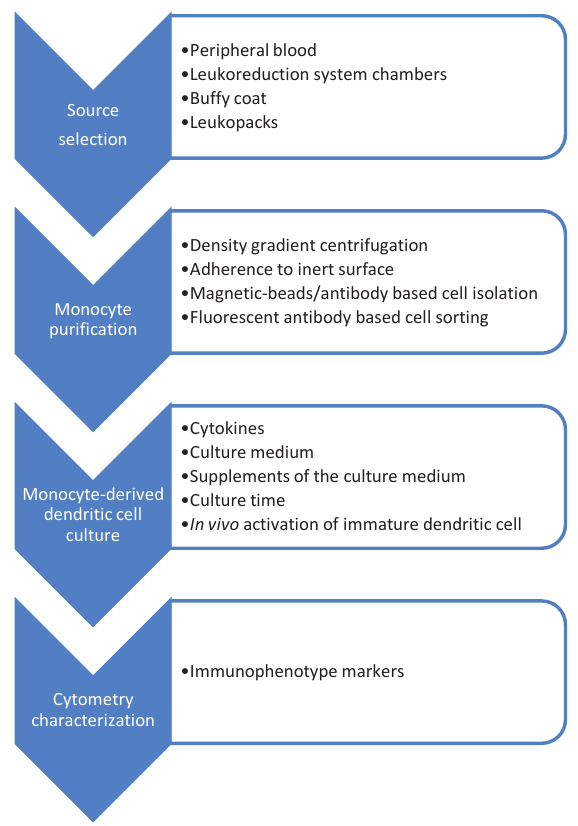
Figure 1 - Scheme of the steps of a MDDC